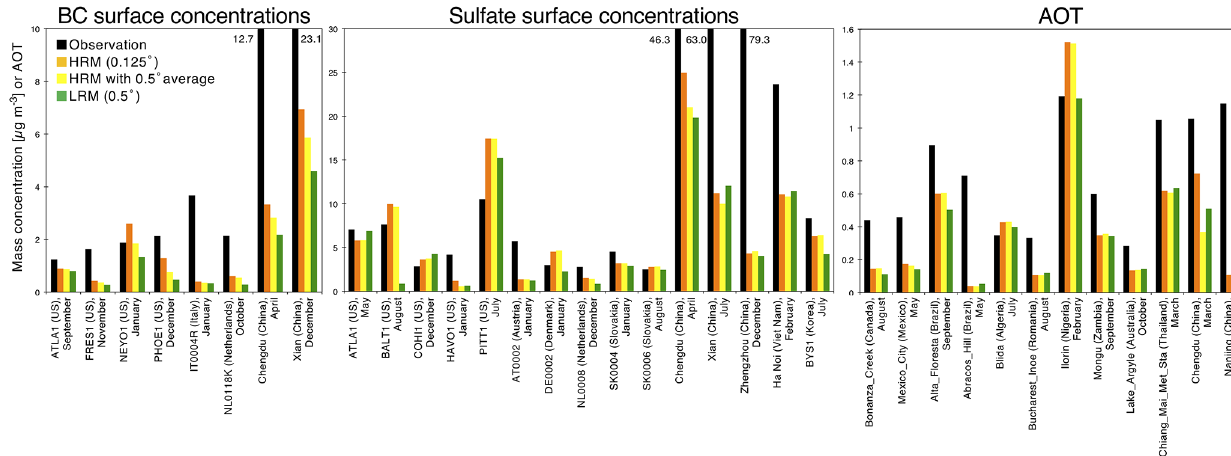
Figure 10. Multiple comparisons of the BC and sulfate surface mass concentrations (µgm − 3 ) and AOTs at the polluted sites using the HRM with an original grid of 0 . 125 ◦ × 0 . 125 ◦ , the HRM with an interpolated grid of 0 . 5 ◦ × 0 . 5 ◦ (denoted as “HRM with 0.5 ◦ average”), the LRM with an original grid of 0 . 5 ◦ × 0 . 5 ◦ and the observations. The abscissa shows the selected sites, which were selected by choosing the highest values at the sites in each domain and